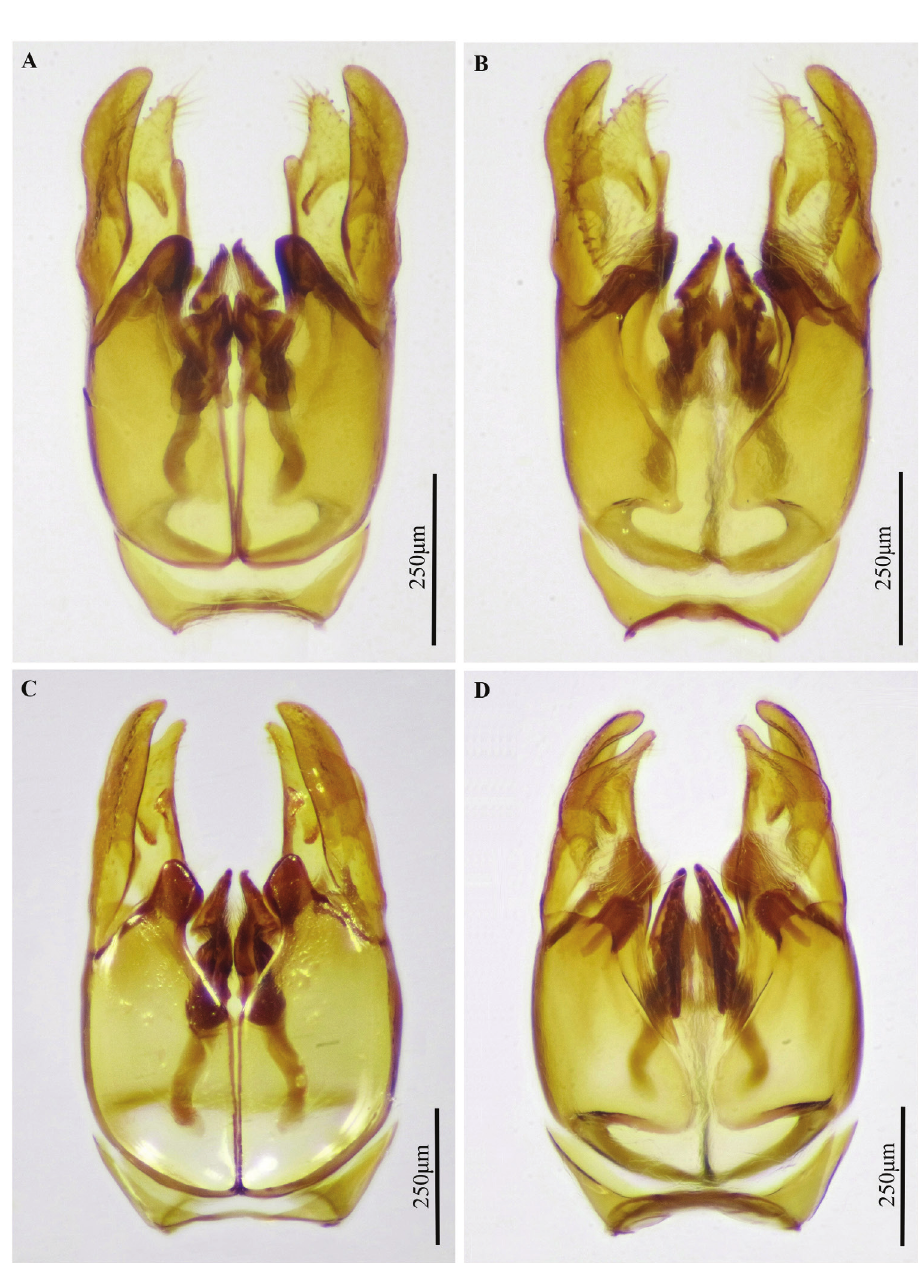
Figure 34. Male genitalia A, B Pseudophotopsis mascatiana Invrea, dorsal and ventral views, respectively C, D P. maura Bischoff, dorsal and ventral views, respectively. foveae mixed with fine punctures; T7 largely foveate on basal half, impunctate api- cally; S2 with small median basal tubercle; S8 (hypopygium) with median apical small